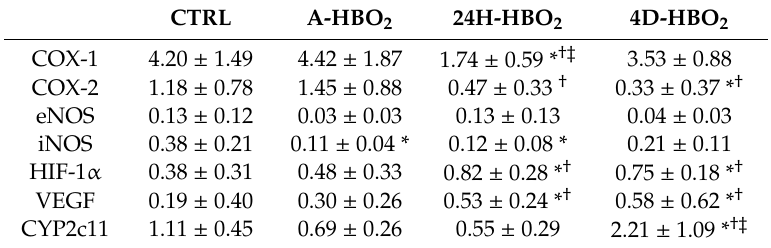
Table 2. Relative mRNA expression of cyclooxygenase 1 and 2 (COX 1 and COX 2), nitric oxide synthase (iNOS and eNOS), hypoxia inducible factor 1 alpha (HIF-1 α ), vascular endothelial growth factor (VEGF) and CYP2C11 in rat aorta normalized to HPRT housekeeping gene .